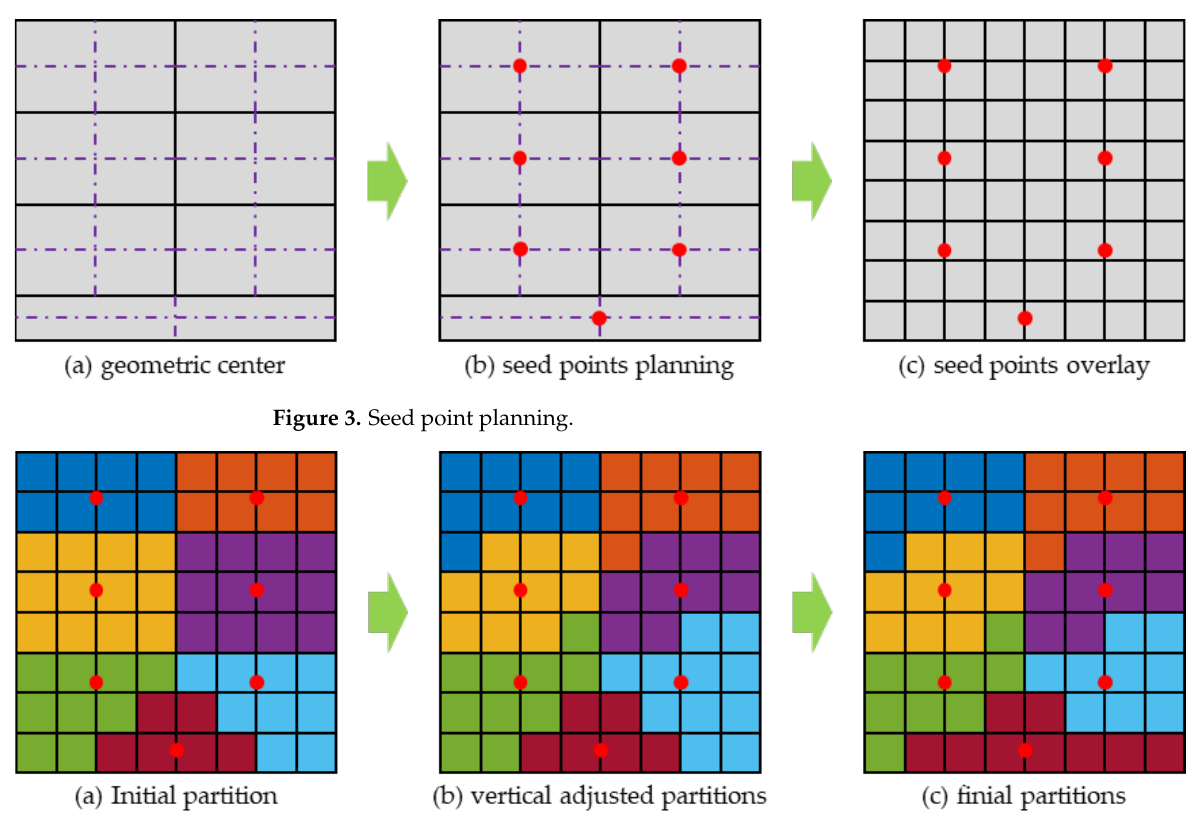
Figure 4. The flowchart for adjustment in the horizontal and vertical directions.